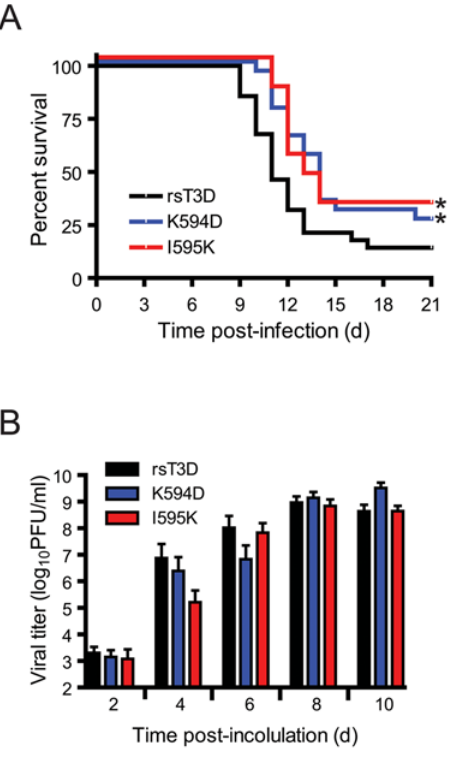
Figure 6. Apoptosis-defective Q mutants display attenuated virulence. ND4 Swiss Webster mice were inoculated intracranially with 50 PFU of rsT3D or the indicated Q mutant. (A) Mice (18–20) were monitored for survival over 21 days. *, P , 0.05 as determined by logrank test in comparison to rsT3D. (B) Brains from infected mice were resected at the times shown and homogenized by freeze-thaw and sonication. Viral titers in brain homogenates were determined by plaque assay. Results are expressed as the mean viral titer (for 6–12 animals). Error bars indicate SD.